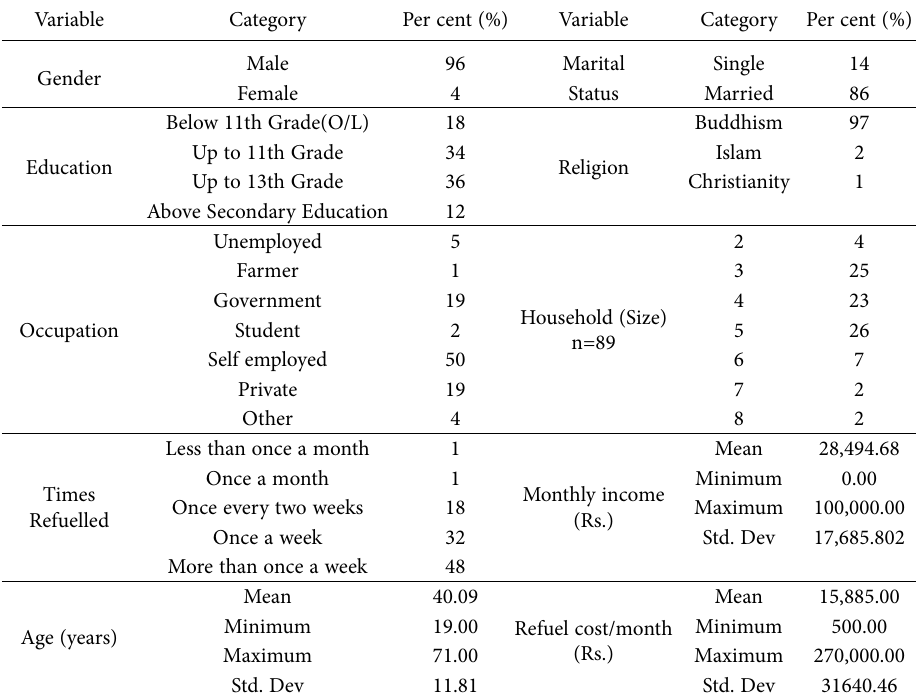
Table 2. Summary profile of the diesel vehicle users.